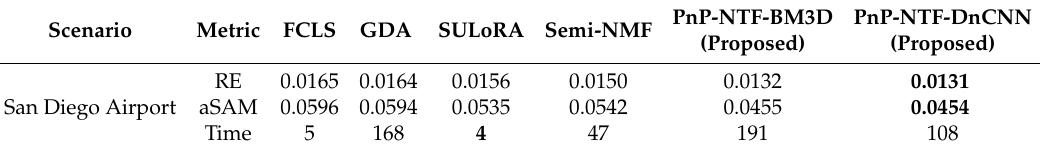
Figure 12. RE distribution maps comparison between the proposed algorithm and state-of-the-art algorithms on the San Diego Airport. Table 7. Evaluation Results with the RE, aSAM and cost time (s) on the San Diego